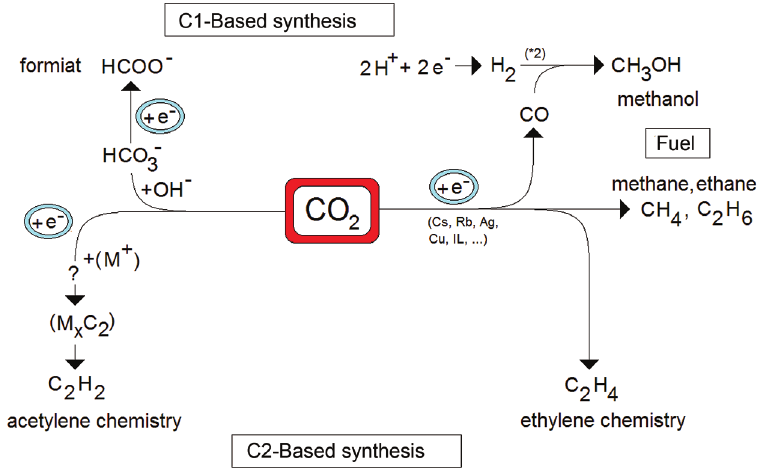
Figure 9 Carbon-based materials production using electrochemical CO